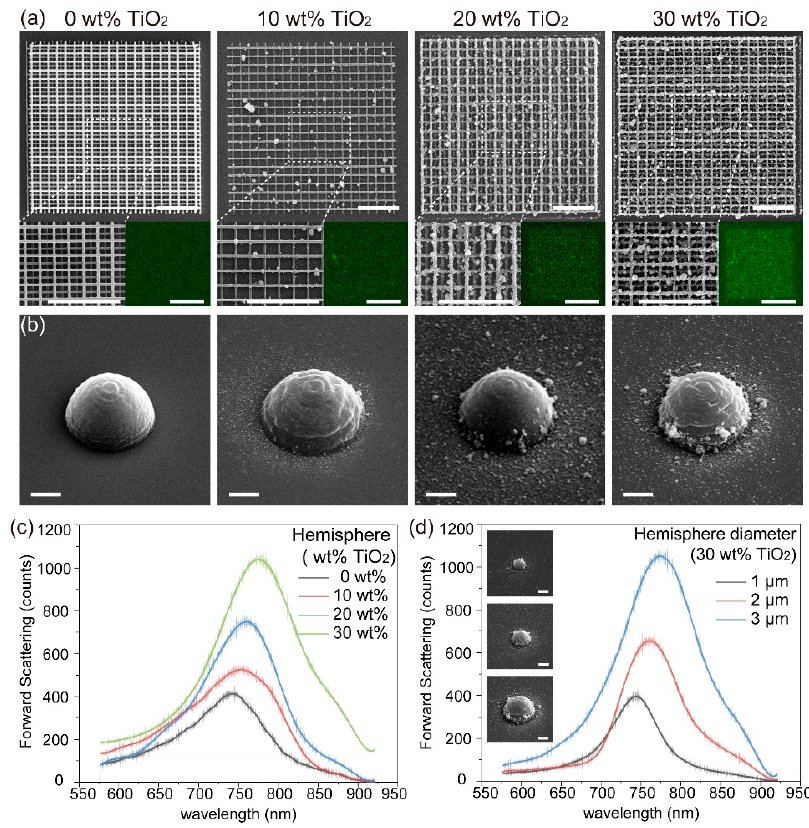
Figure 4. ( a ) The SEM images of the as-fabricated TiO 2 -based of woodpile-like structures. Insets: the enlarged SEM imaged of the dashed boxes and compositions of Ti element. The scale bars are 5 μ m. ( b ) The SEM images of the as-fabricated hemispheres with expected diameters of 3 μ m. ( c ) The corresponding forward scattering spectra of ( b ). ( d ) The forward scattering spectra of three different hemispheres with the same concentration, 30 wt%. Insets: SEM images of corresponding hemispheres. The scale bars in ( b ) and ( d ) are 1 μ m.